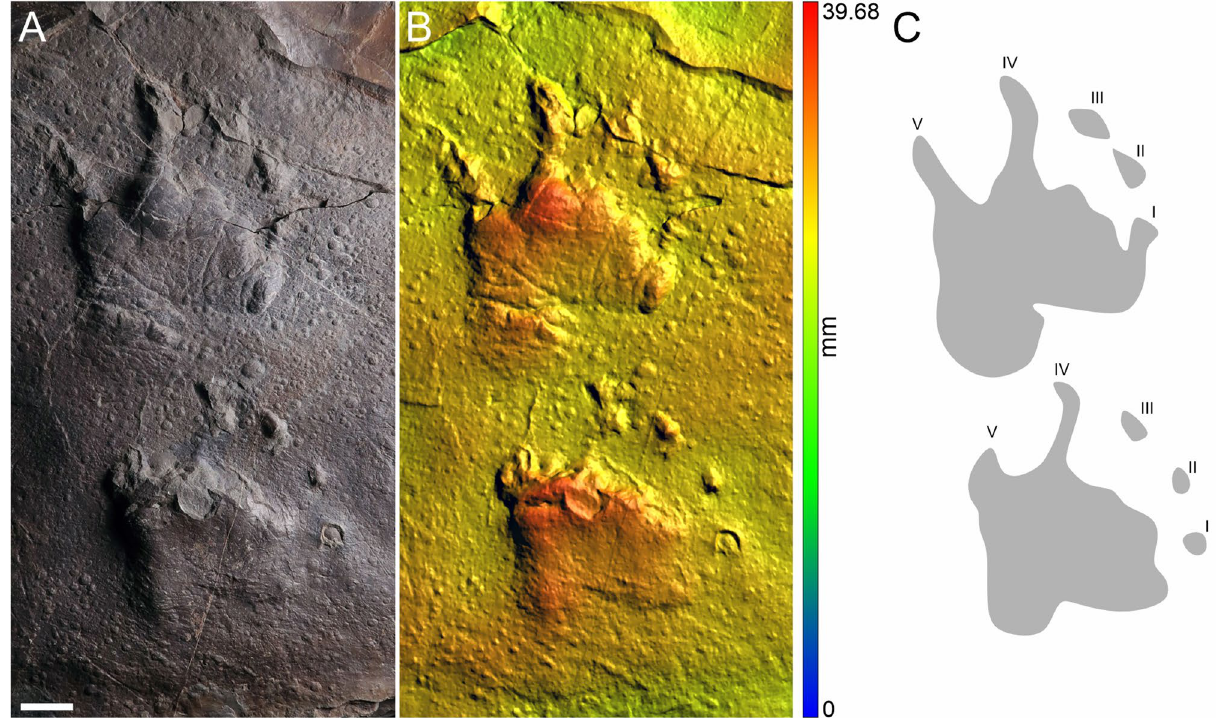
Figure 2. The manus-pes couple of MZM Ge 29610 (convex hyporelief) ( A ), image ‐ based modeling ( B ), and the outline drawing ( C ). Scale bar 2